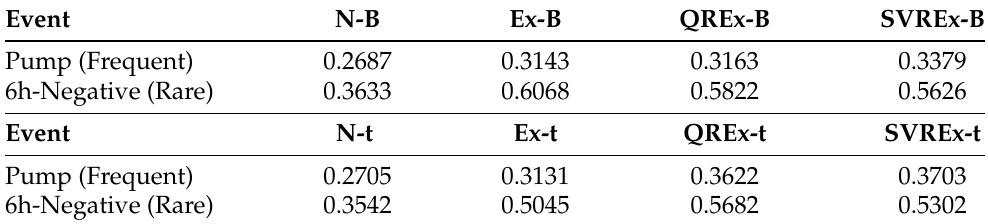
Table 7. Event-based Evaluation: